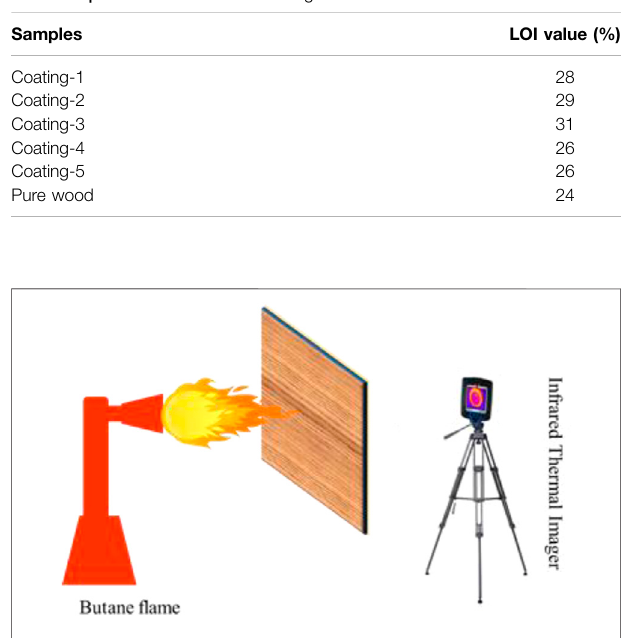
FIGURE 7 | The device to test the back temperature when the coated surface is exposed in the butane fl ame.